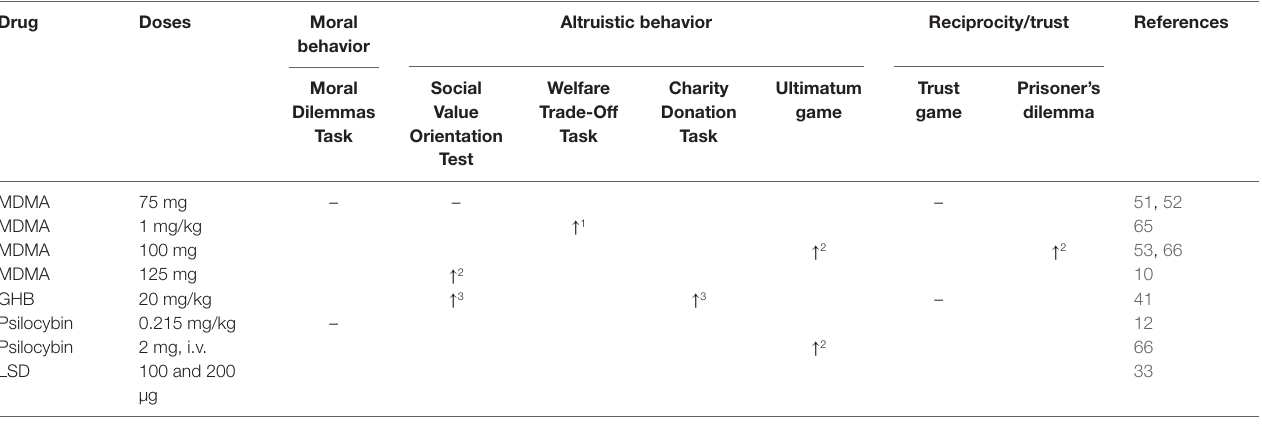
TABLE 2 | Effects of entactogens and hallucinogens on moral and altruistic